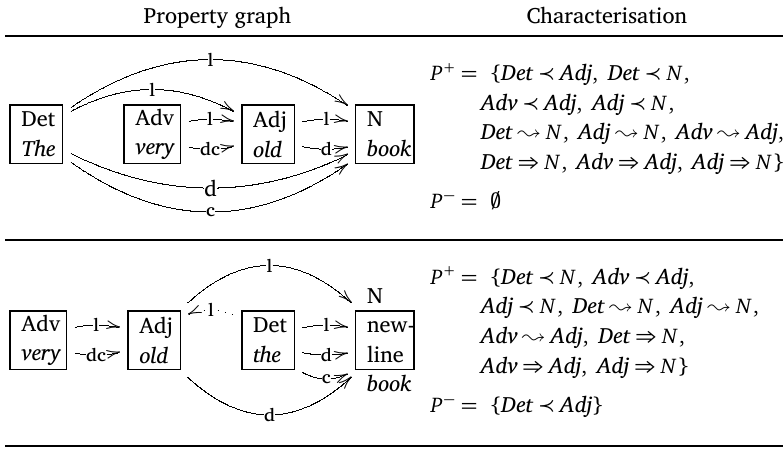
Table 8: Characterisations of nominal constructions Property